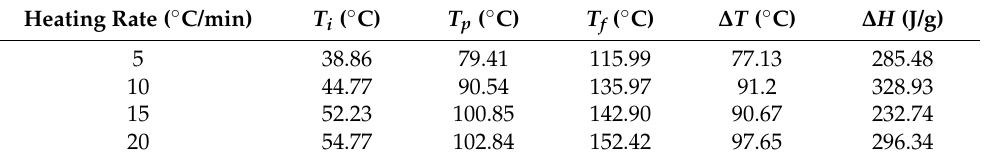
Figure 2. DSC results of 3M DP420 epoxy adhesive: ( a ) dynamic DSC curves of epoxy adhesive at different heating rates; ( b ) characteristic curing temperature; ( c ) curing degree as a function of temperature. Table 1. Characteristic parameters of curing process at different heating rates.